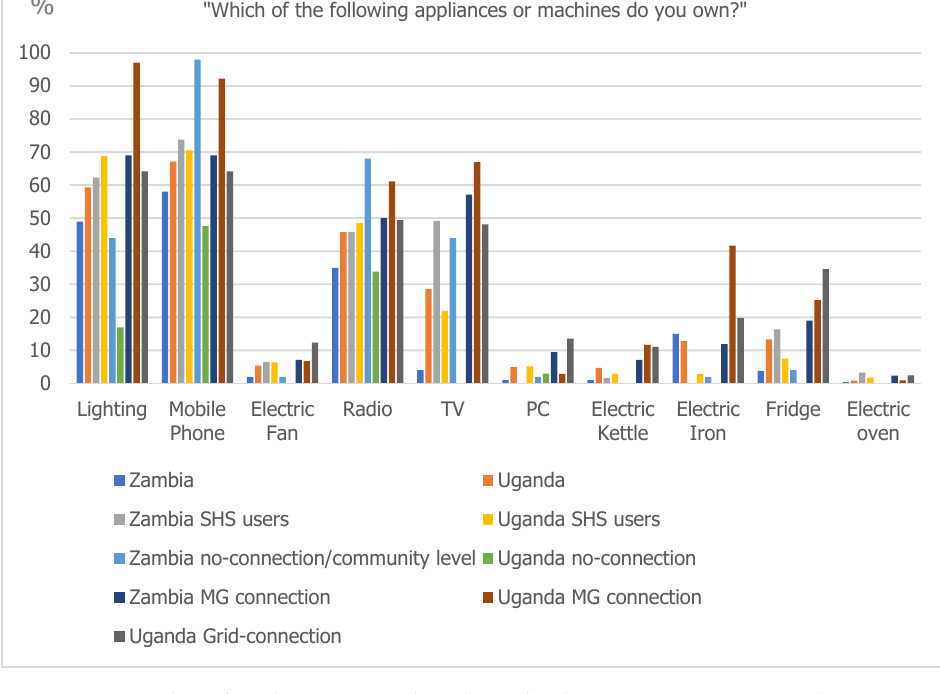
Figure 5. Ownership of appliances, Uganda and Zambia (Responses in %; N = 1037).